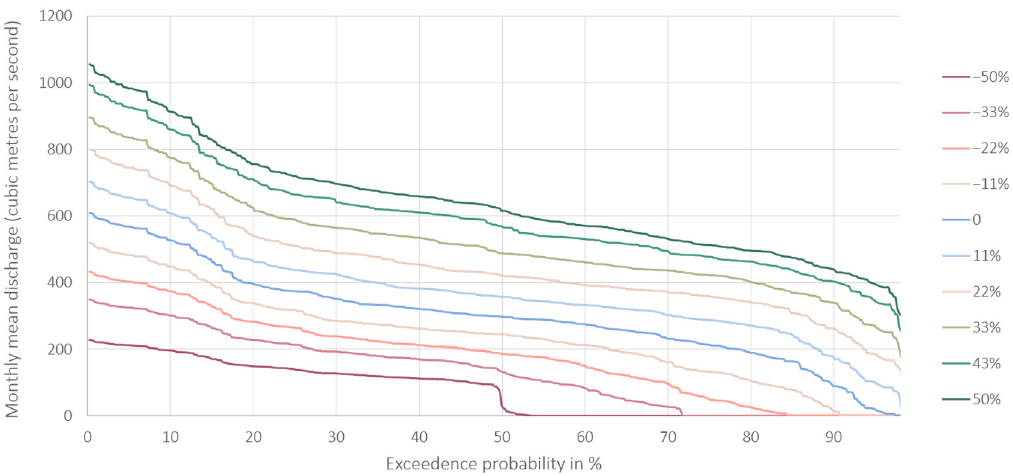
Figure 6. Flow duration curves of the Ili river for different precipitation scenarios ( − 50% to +50%) under stable temperature and current demands in the upper Ili Valley.